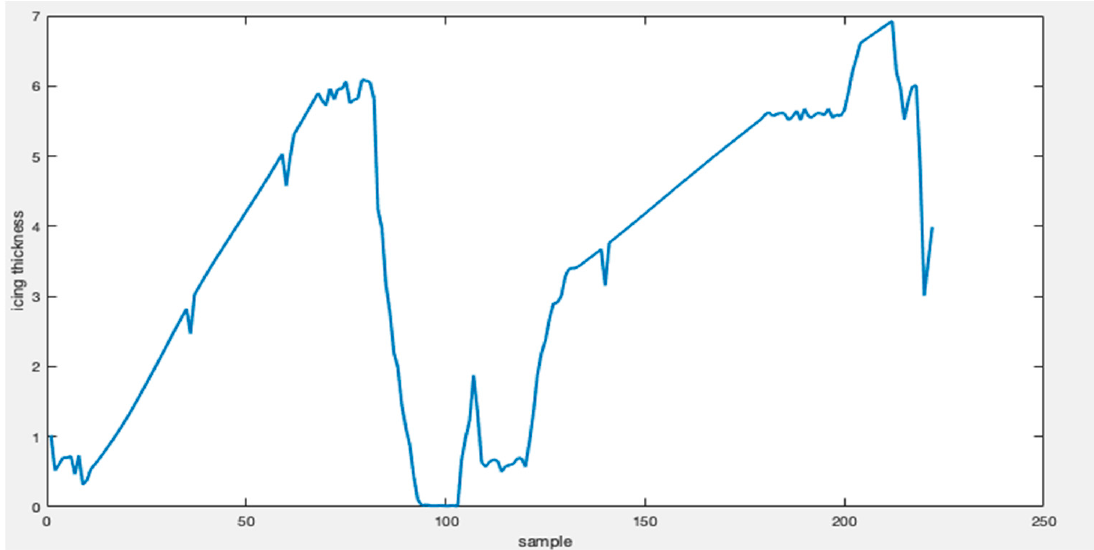
Figure 15. The trend of icing thickness of “front flat line 95.”